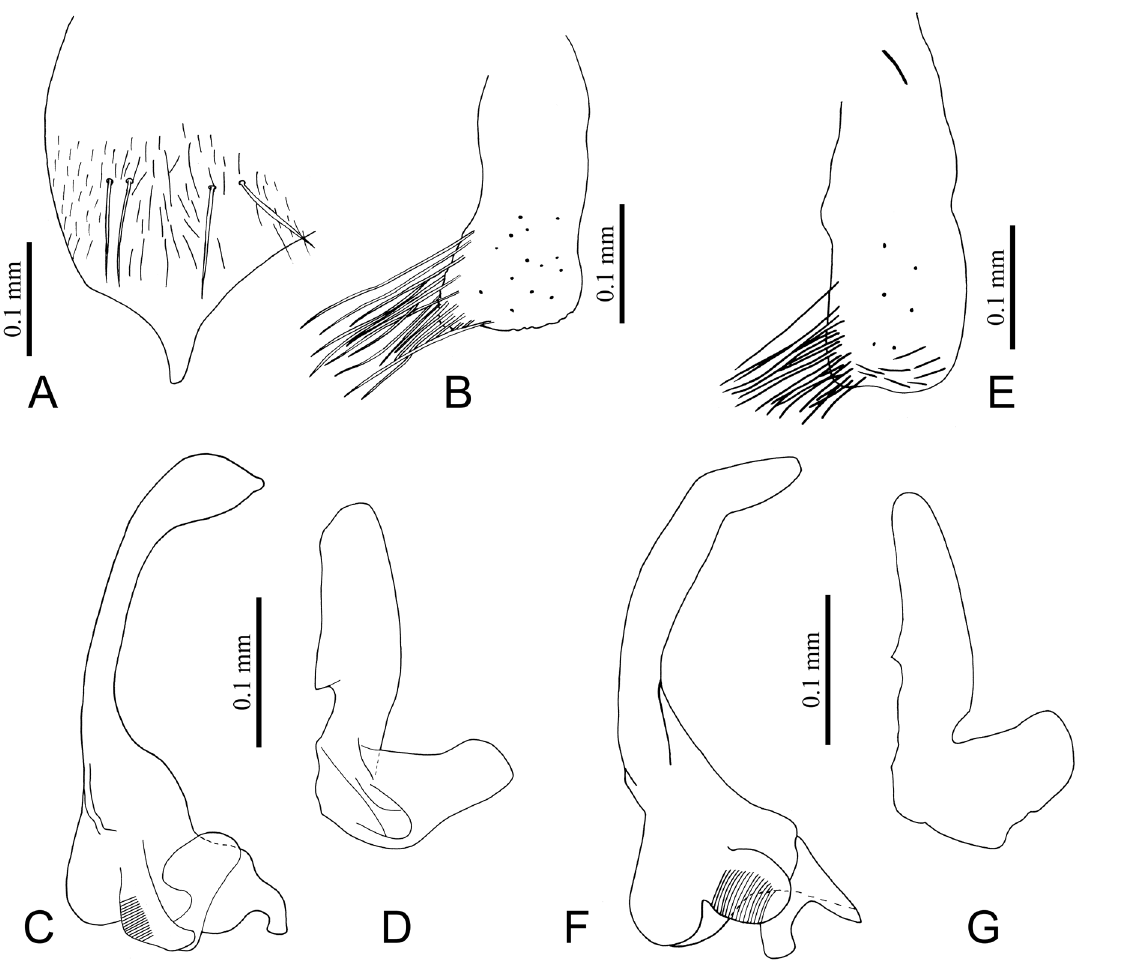
Fig. 14. Morphological features of species of Micronecta Kirkaldy, 1897, ♂♂. A–D . M. ornitheia Nieser, Chen & Yang, 2005 (ZVNU). E–G . M. tuwanoni Nieser, Chen, Leksawasdi, Thanyakam & Duangsupa, 2004 (ZVNU). A = median lobe of sternite VII; B, E = free lobe; C, F = right paramere; D, G = left